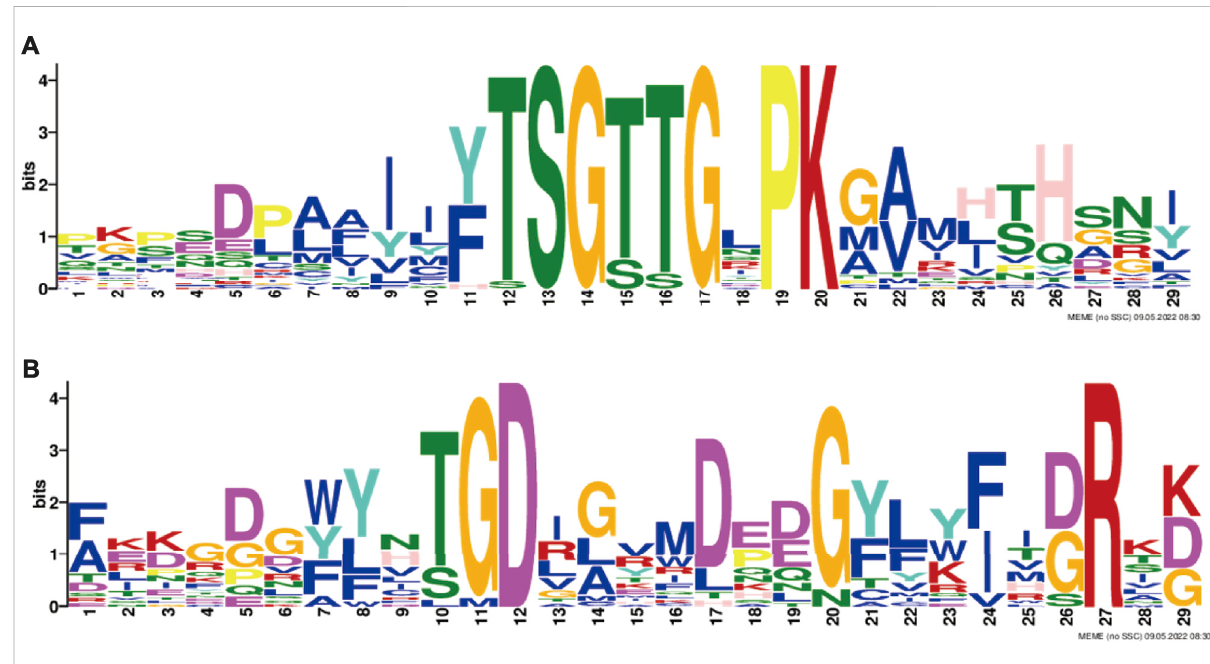
FIGURE 6 The conserved (A) motif 1 and (B) motif 3. Legends: These logos are graphic representations of amino acid sequences obtained from multiple sequence alignments. The motif 1 and motif 3, both of which were all components of the AMP-binding domain and played vital roles in substrate binding and/or catalysis (Watkins et al., 2007). The larger the fonts, the more conserved the